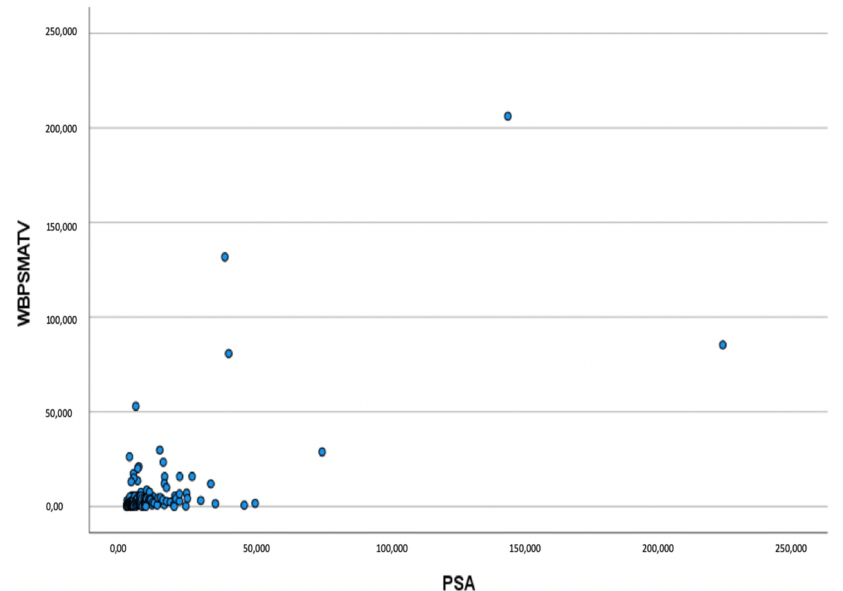
Figure 1. Scatterplot showing the correlation between baseline PSA (ug/L) levels and whole-body PSMA-TV (WBPSMATV).